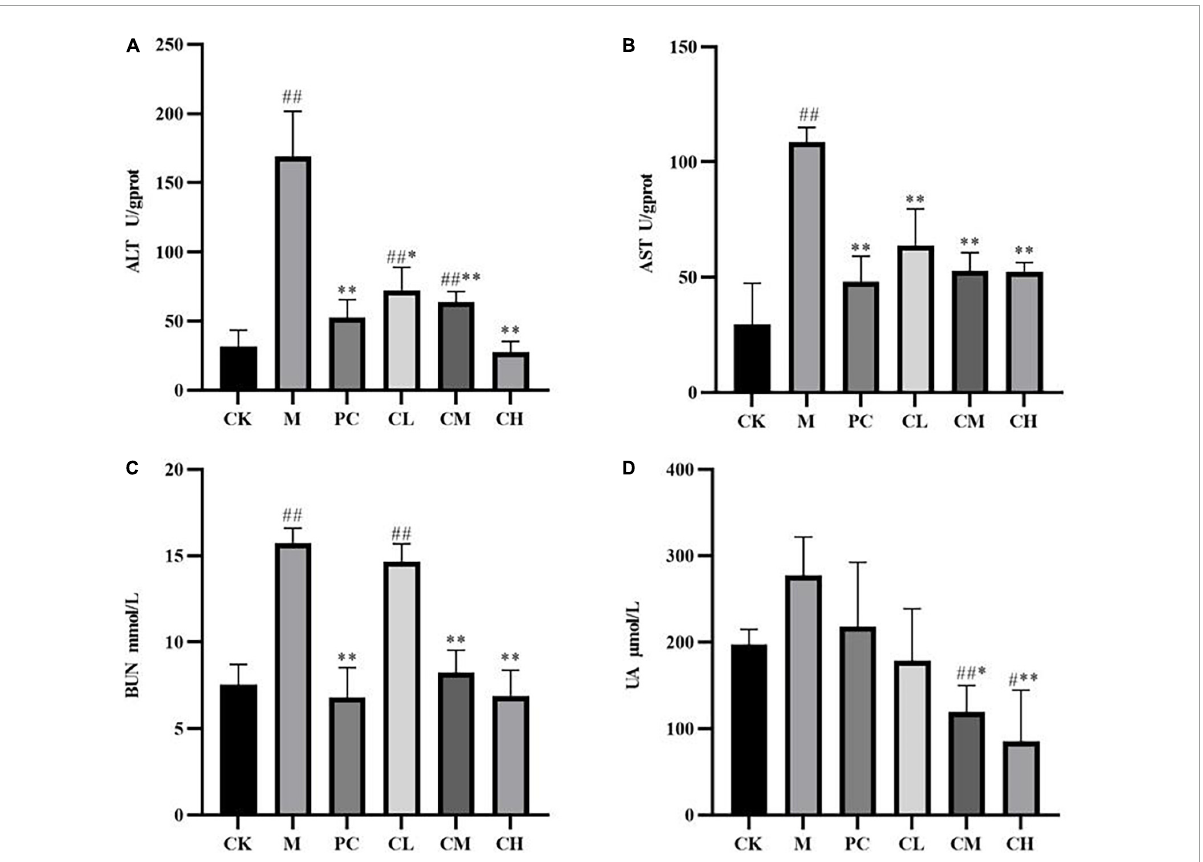
FIGURE3 Effect of samples on liver ALT (A) , AST (B) , and renal BUN (C) , UA (D) activity in mice. (Compared with the M group, * indicates P < 0.05, ** indicates P < 0.01; compared with the CK group, # indicates P < 0.05, ## indicates P <